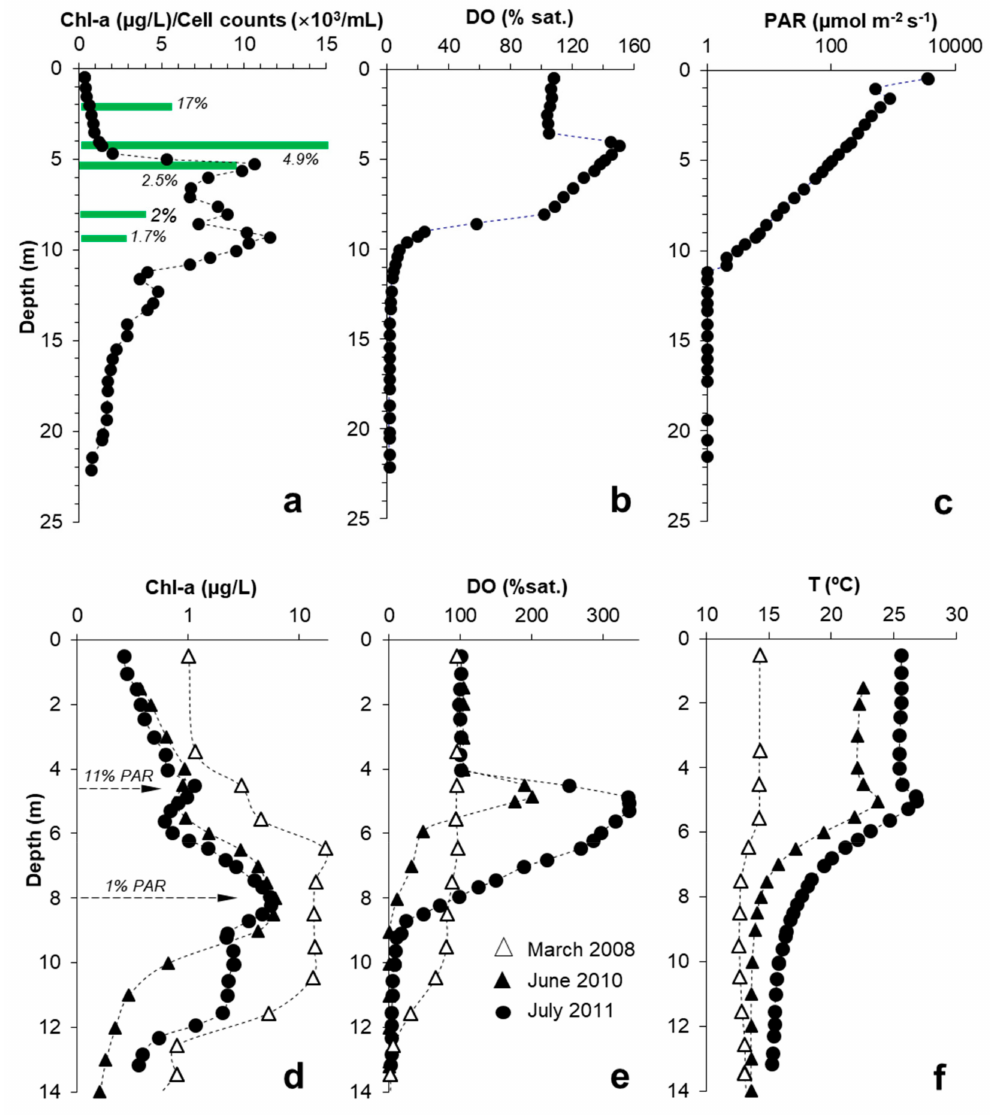
Figure 6. Top: Depth profiles of Chl-a concentration ( a ), DO concentration ( b ) and PAR ( c ) measured in July 2011 in Cueva de la Mora. The horizontal green bars in (a) indicate cell counts of phytoplankton measured at selected depths. The numbers in italics shown for each bar indicate the corresponding PAR intensity (with respect to that measured at the lake surface) in every case. Bottom : Depth profiles of Chl-a concentration ( d ), DO concentration ( e ) and temperature ( f ) obtained in three di ff erent seasons in the photic zone of Herrer í as-Guadiana. The arrows in (d) indicate the PAR intensity (as % of that measured at the lake surface) in the two major Chl-a